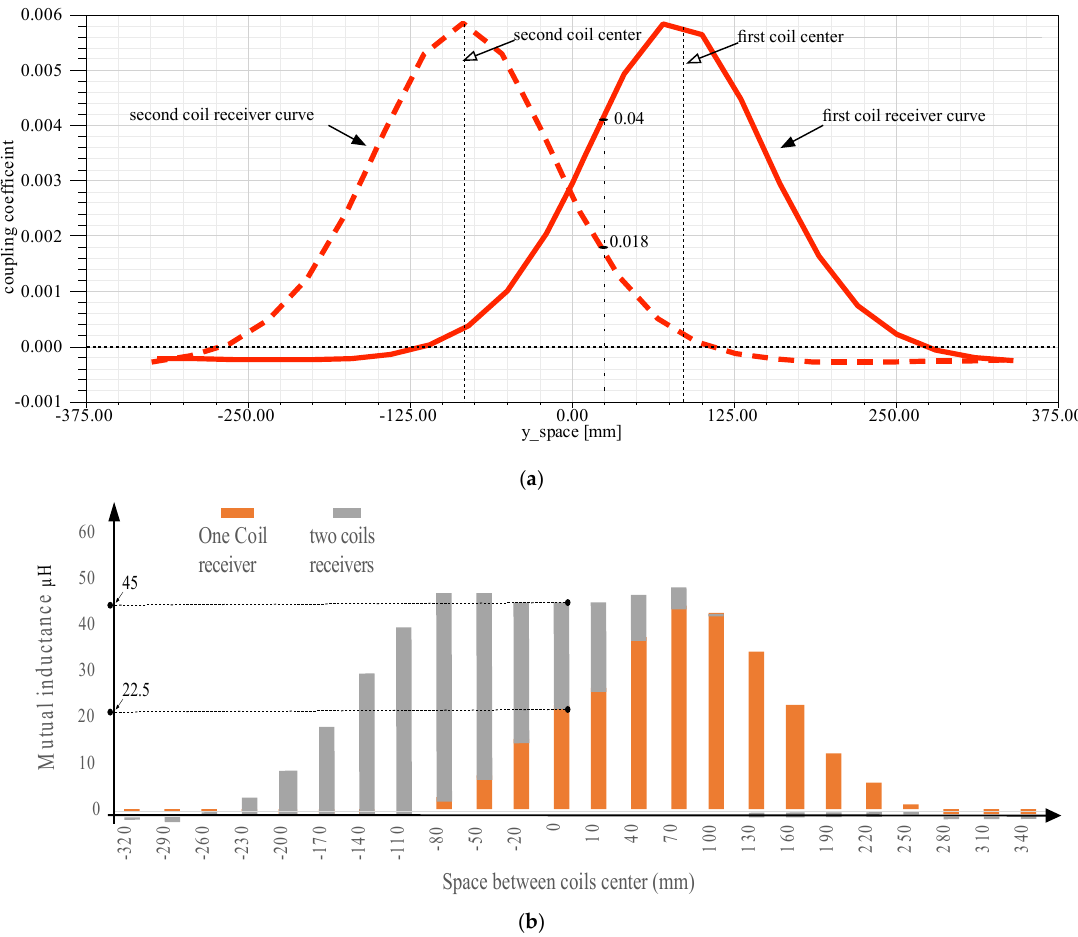
Figure 11. ( a ) Coupling coefficient for each receiver coil proportionally to the transmitter position, ( b ) Mutual inductance for only one receiver coil, and the totally mutual inductance for two receivers coil proportionally to the coil transmitter position.